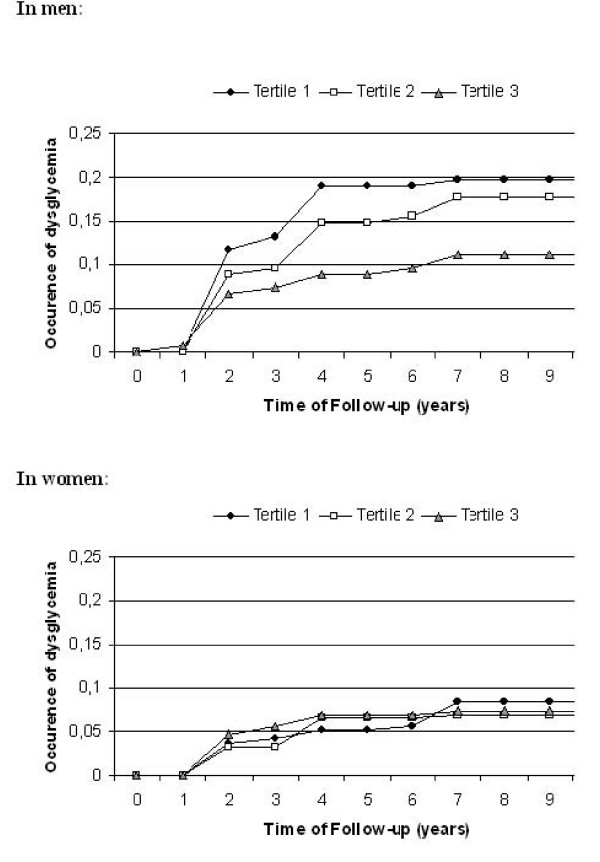
Occurrence of dysglycemia by tertile of plasma selenium in men (a) and in women (b). Tertile 1: 0.18-1.00 μmol/L (median value = 0.90 μmol/L). Tertile 2:1.01-1.18 μmol/L (median value = 1.09 μmol/L). Tertile 3: 1.19-1.94 μmol/L (median value = 1.29 μmol/L). Black circle: Tertile 1; White square: Tertile 2; Grey tangle: Tertile 3.